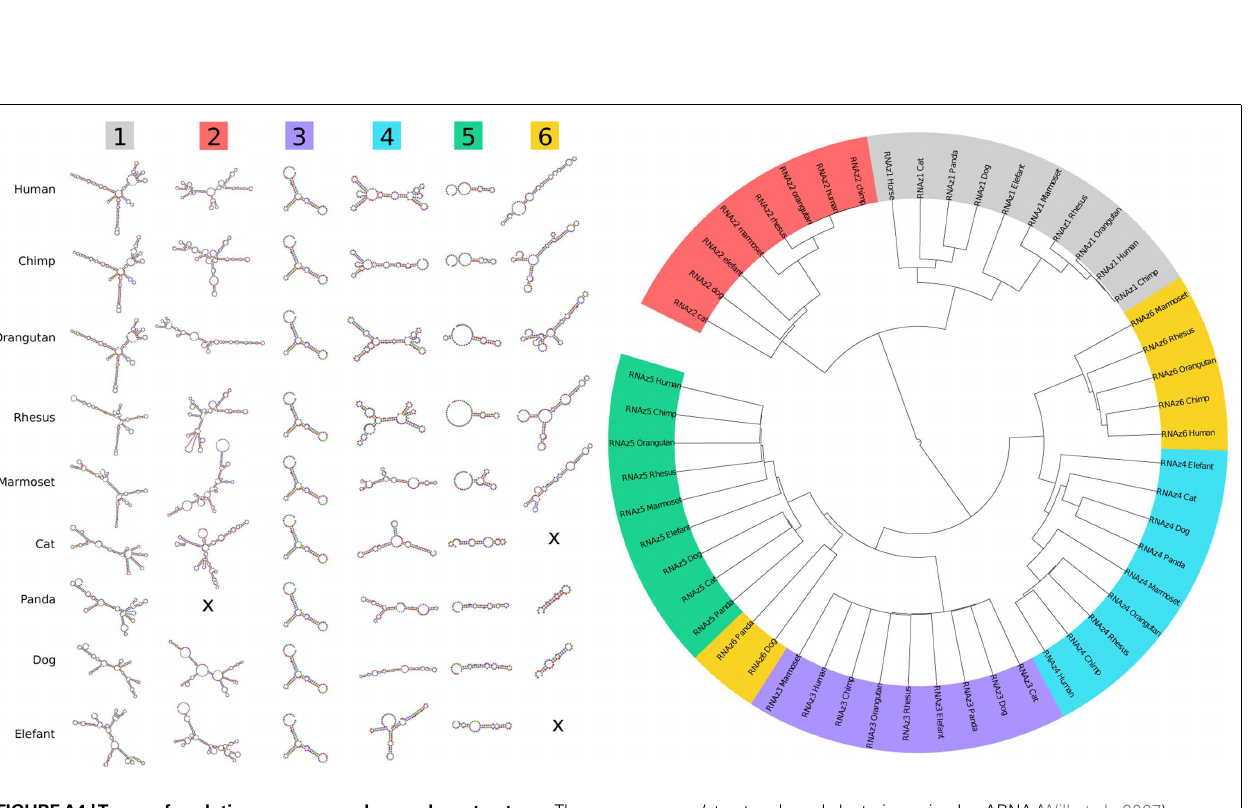
FIGUREA4 |Traces of evolutionary conserved secondary structures. The minimum free energy structures of the six RNAz-predicted regions are at least partially conserved throughout higher eukaryotes. A